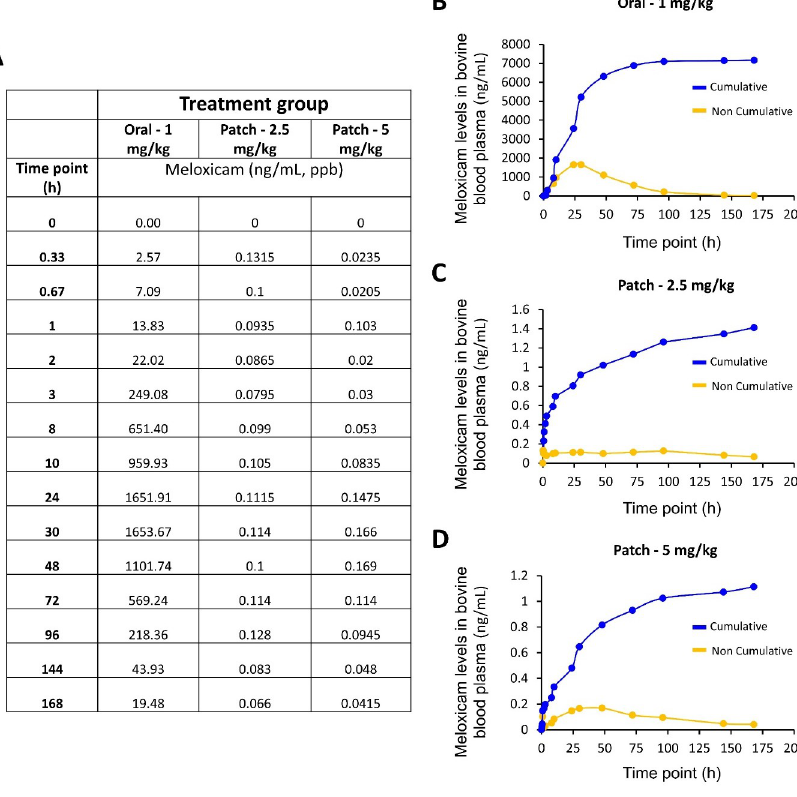
Fig 8. Meloxicam levels in bovine blood plasma. A) Raw data (average), B) Oral -1 mg/kg, C) Patch -2.5 mg/kg, D) patch—5 mg/kg. Data are presented as the mean ± standard deviation of n = 2 samples per